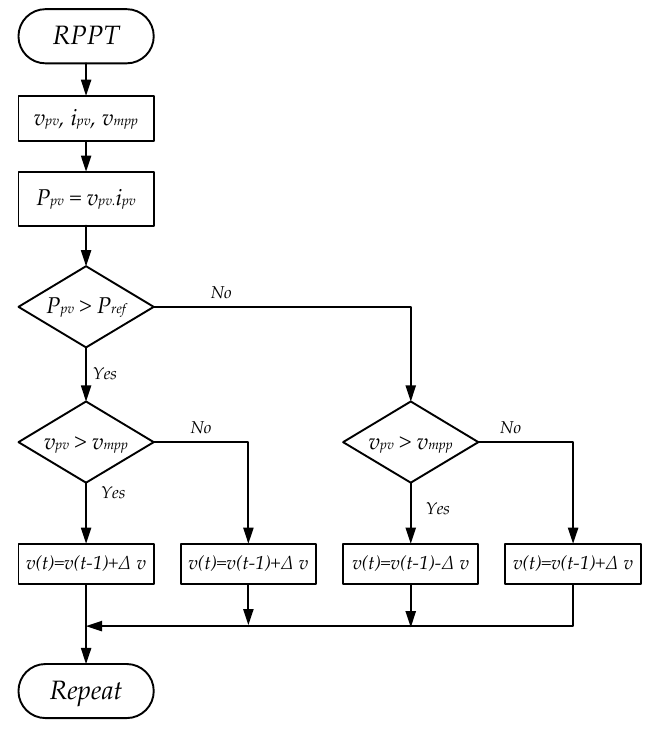
Figure 10. RPPT control algorithm.